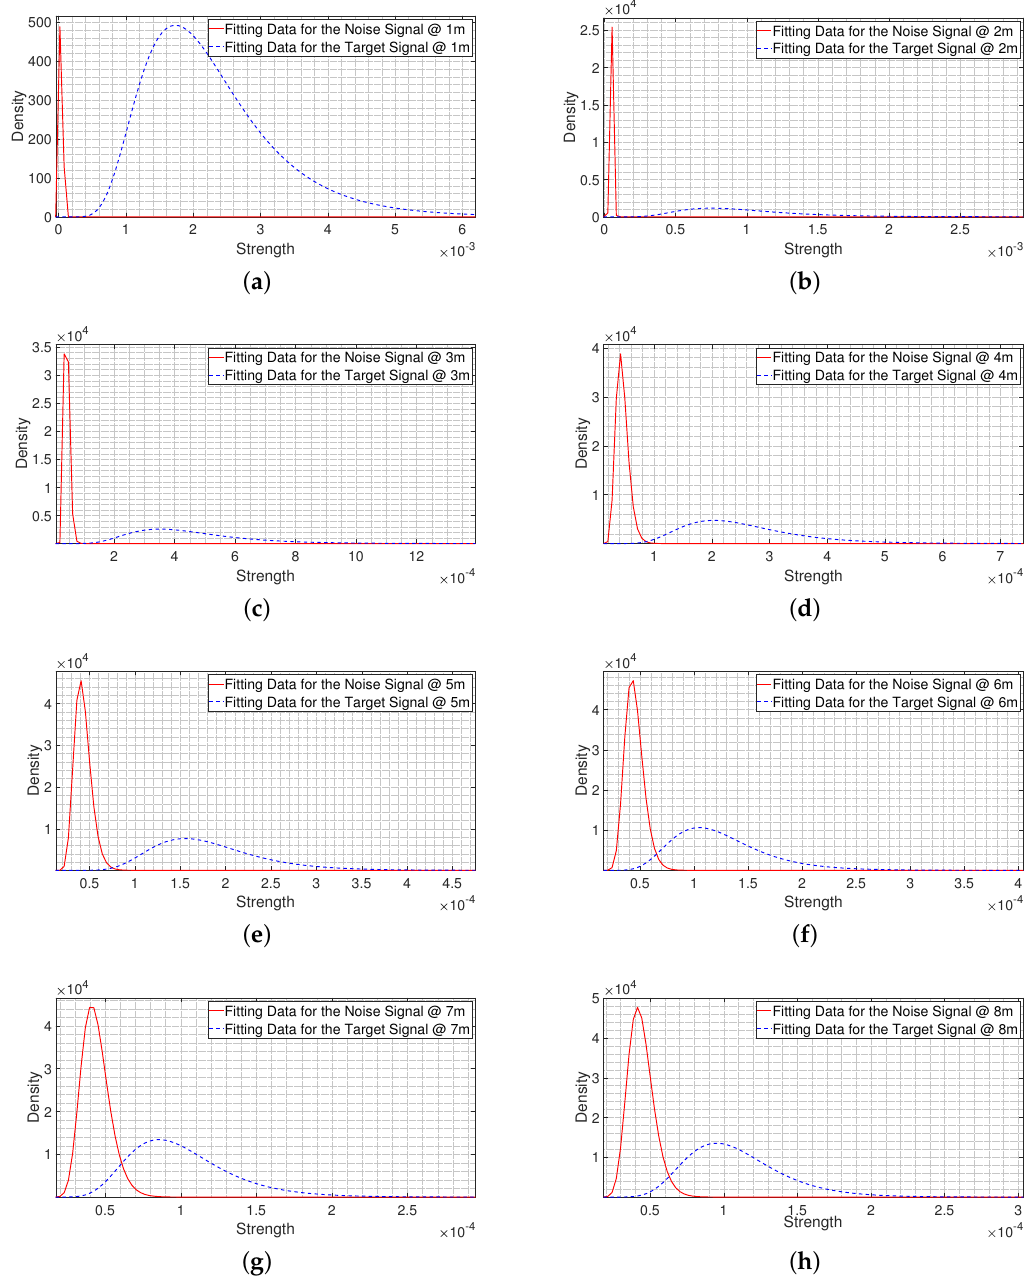
Figure 15. The fitting results from 1 m to 8 m in a heavy clutter environment. ( a ) The fitting result at 1 m. ( b ) The fitting result at 2 m. ( c ) The fitting result at 3 m. ( d ) The fitting result at 4 m. ( e ) The fitting result at 5 m. ( f ) The fitting result at 6 m. ( g ) The fitting result at 7 m. ( h ) The fitting result at 8